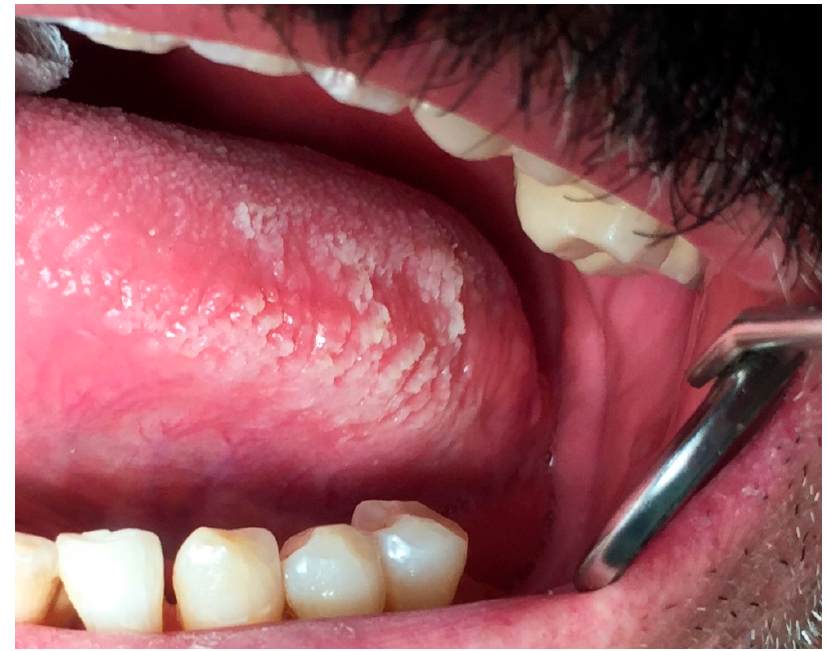
Figure 9. Oral hairy leukoplakia on the lateral border of the tongue with vertical white